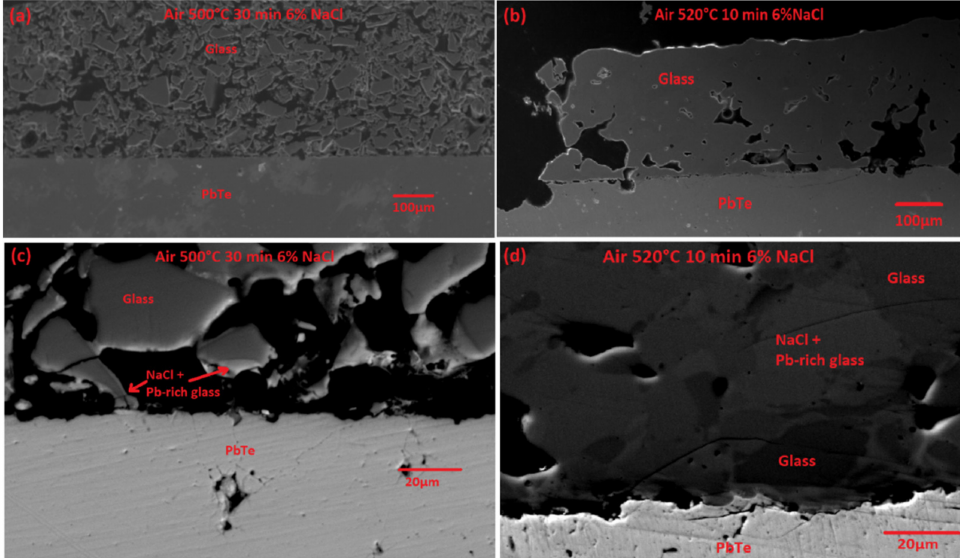
Figure 7. SEM micrographs following coating and subsequent thermal treatment at either a lower temperature of 500 ◦ C ( a , c ) or shorter duration of 10 min. ( b , d ), compared to the previously applied 520 ◦ C / 30 min. condition. ( a , b ) are secondary electrons images while ( c , d ) are back scattered electrons